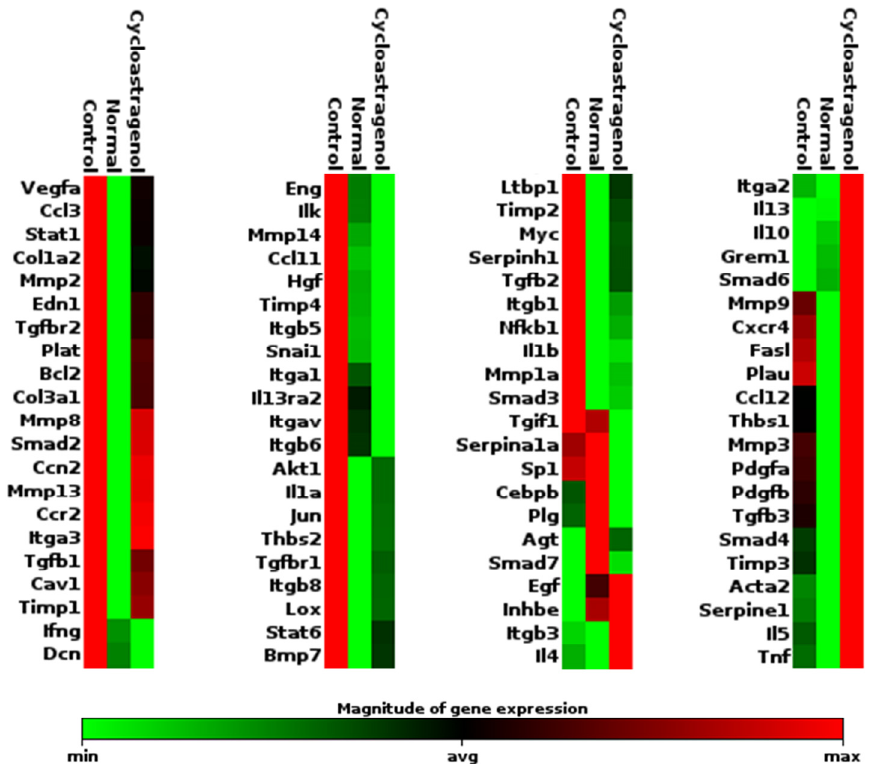
Figure 2. Effects of cycloastragenol (200 mg/kg) on the expression 84 fibrosis-related genes in the liver of mice treated with carbon-tetrachloride. Relative mRNA expression of each gene when compared with the normal are indicated using arrays of colors in a heat-map clustogram, representing a sample among each group, is shown.